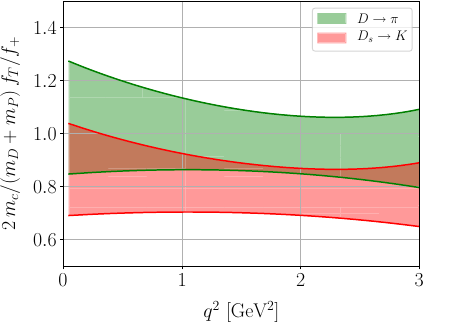
Fig. 12 The q 2 –dependence of the factor γ = 2 m c Eq. (12) for D → π (green) and D s → K (red)